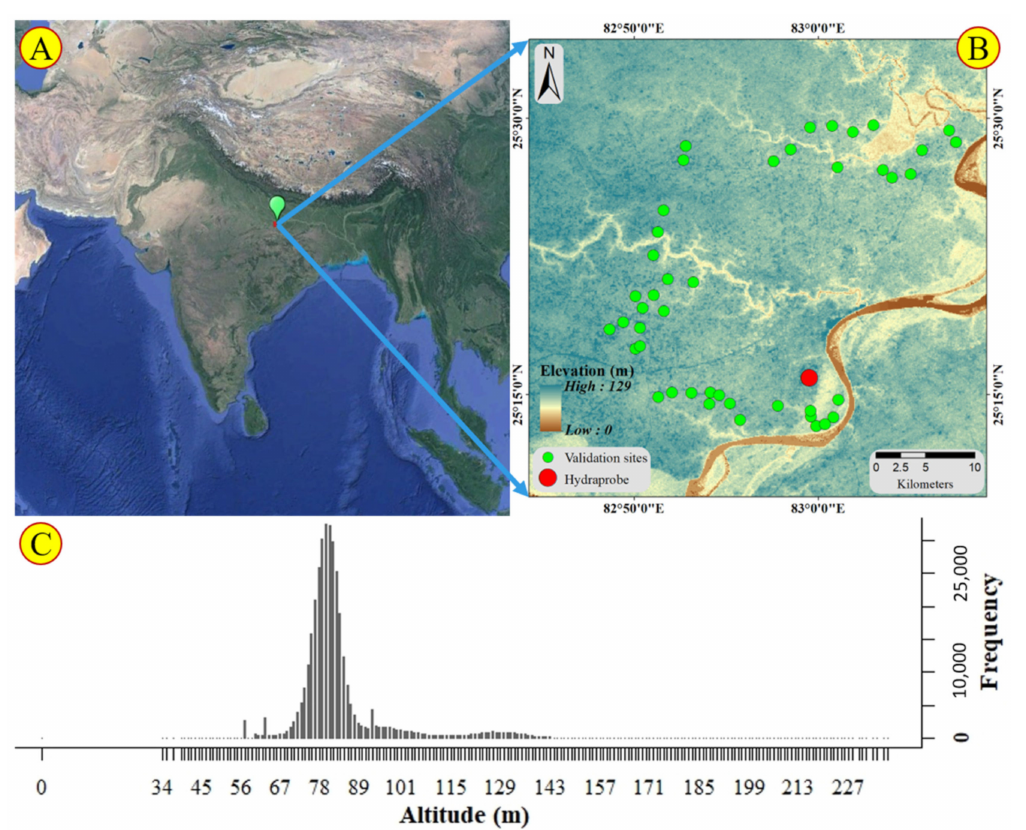
Figure 1. ( A ) Geographical location of the study area in the Indian sub-continent. ( B ) Geographical extent of the study area along with spatial distribution of validation sites and the location of Hy- draProbe at the validation site. Red dot represents the HydraProbe site, where Stevens HydraProbe soil moisture sensor is permanently installed. Green dots represent the 44 validation sites, where surface soil moisture is obtained for six random days during the study through gravimetric analysis. ( C ) Distribution of altitude in the study area from